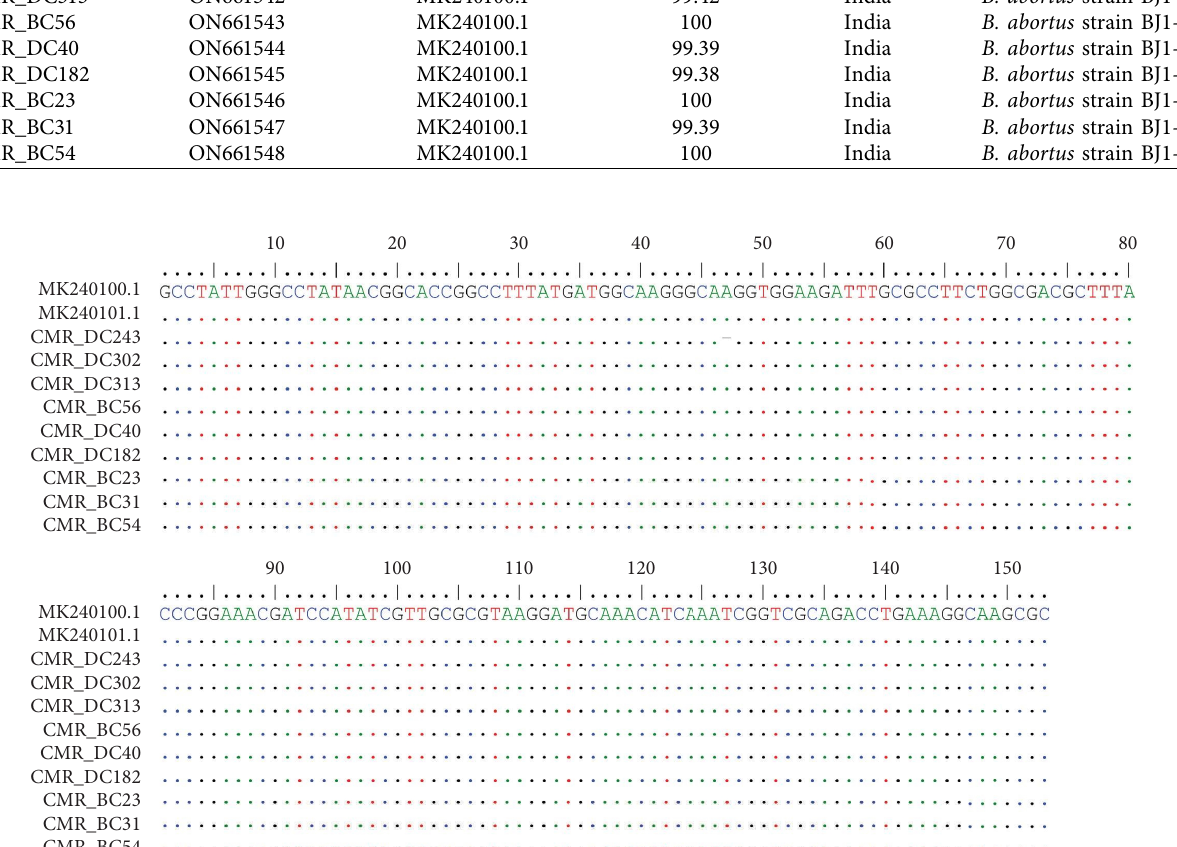
Figure 4: ClustalW alignments of the bcsp31 DNA sequences between local sequences in this study and reference sequences. Dots represent identical nucleotides. – represents deletion of a